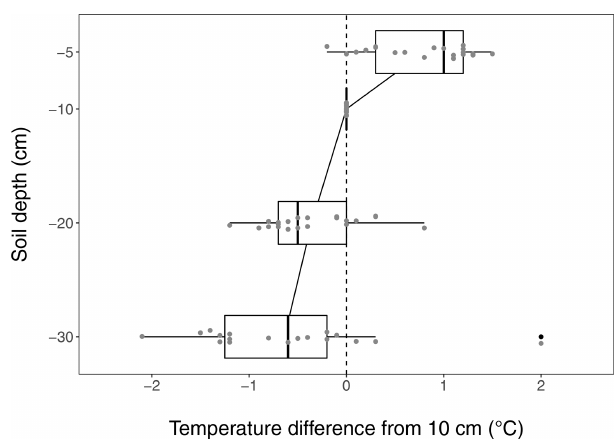
Figure B4. Soil warming along the vertical soil profile, based on the reference temperature measured at 10cm which is used through- out the paper. The median temperature is about 1 ◦ C higher at 5cm depth while being slightly lower at 20 and 30cm depth. Due to the shallow soil in the medium-term warmed grassland, the warming profile is given for the long-term warmed grassland only.